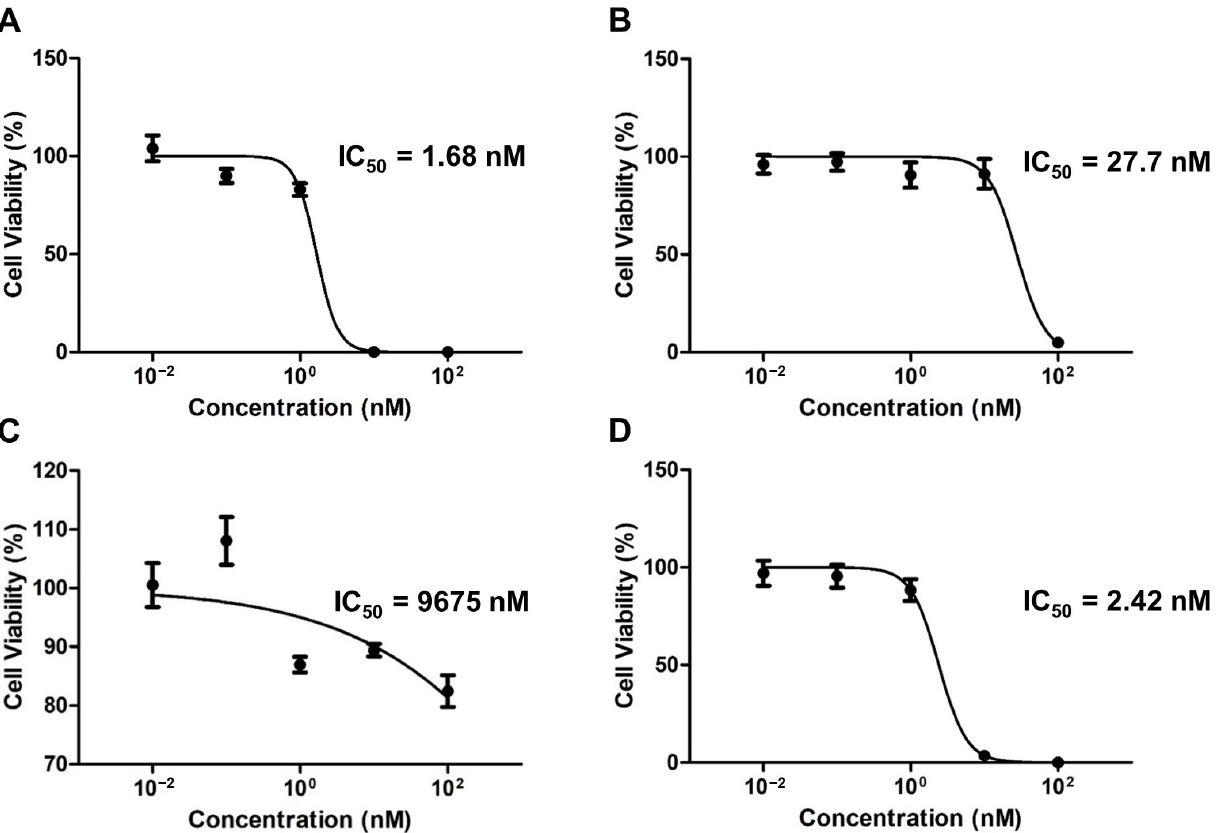
Figure 4. In vitro clonogenic analysis of AGS-Luc2 cells after two weeks of treatment with ( A ) PTX-loaded mPEG-pH-PCL micelles, ( B ) ETP-loaded mPEG-pH-PCL micelles, ( C ) RAPA-loaded mPEG-pH-PCL micelles, and ( D ) PTX/ETP/RAPA-loaded mPEG-pH-PCL micelles (n = 3).